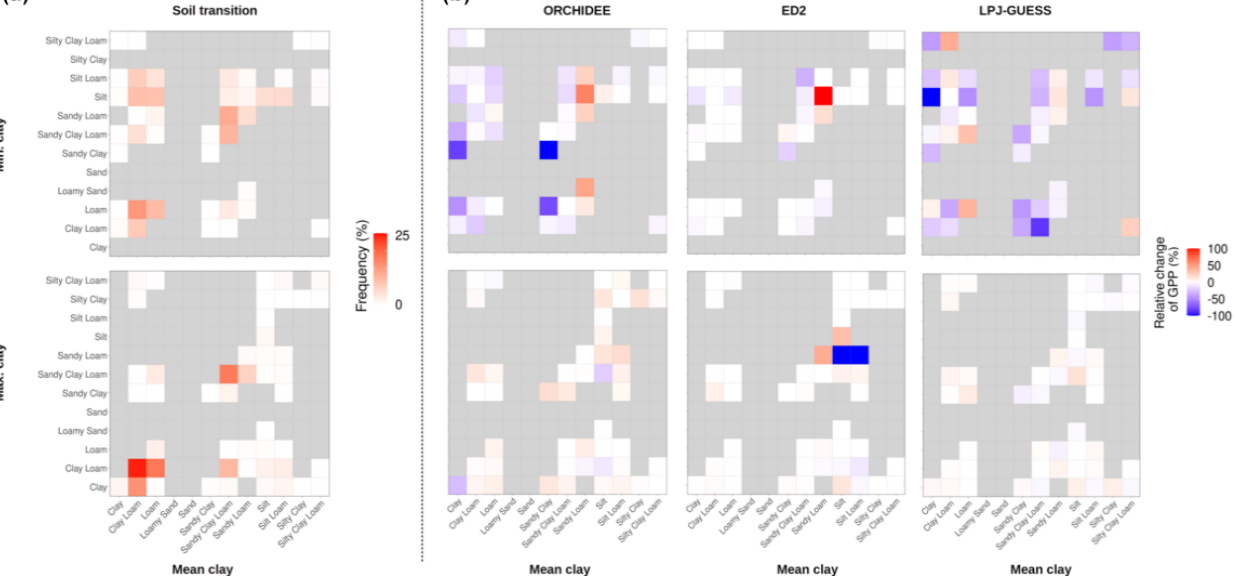
Figure 5. Soil transition matrix representing the frequencies of moving from one soil class to another when changing the soil-textural map (a) and the relative change of ecosystem gross primary production (GPP) for each category of transition and terrestrial biosphere model (b) as predicted by each TBM at the end of the historical period. In (a) , the colour intensity represents the frequency of each transition. The grey cells are transitions that did not occur in the simulated